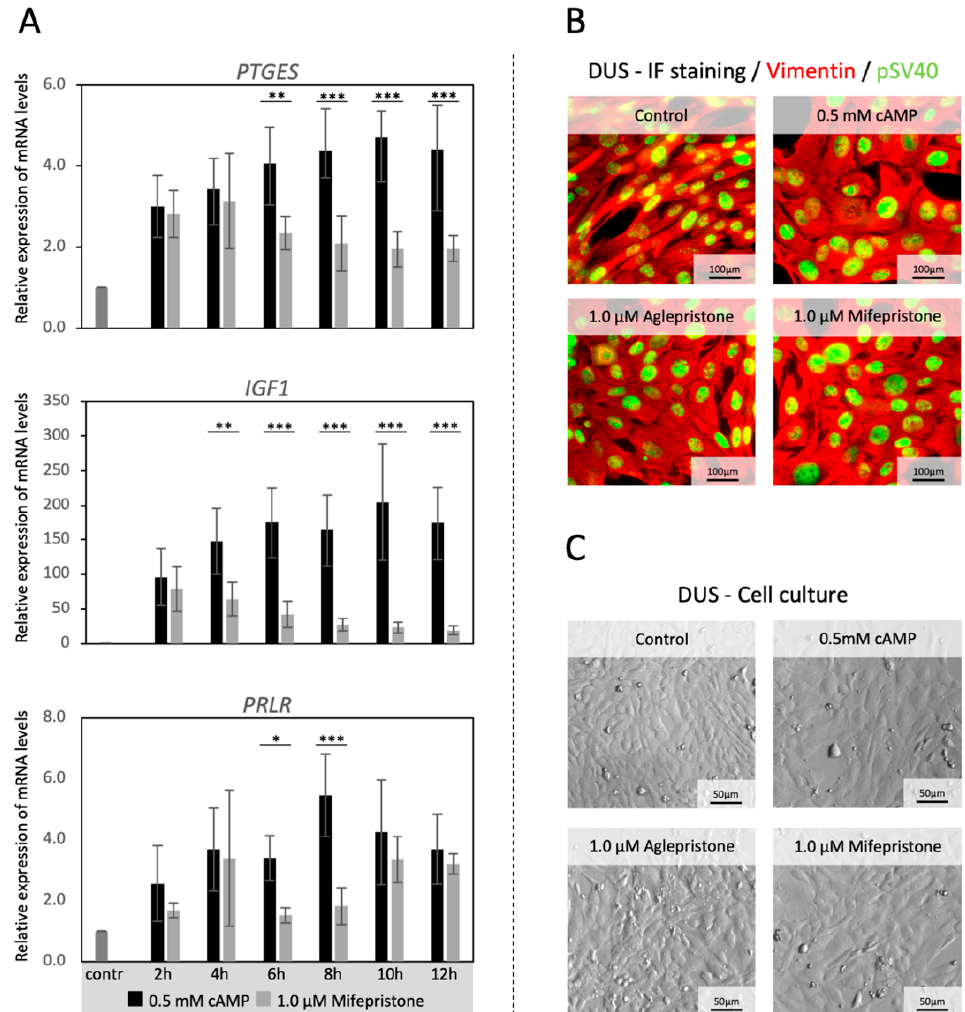
Figure 1. Time-dependent effects of mifepristone on the availability of decidualization markers in DUS cells. ( A ) Decidualized DUS cells (0.5 mM cAMP, 72 h) were treated with 1 μ M mifepristone for up to 12 h. The relative gene expression of prostaglandin E2 synthase ( PTGES ), prolactin receptor ( PRLR ), and insulin-like growth factor ( IGF )-1, was evaluated at different time points of treatment and compared with control cells. Two-tailed Student’s t-test was applied at each time point. Nu- merical data are presented as mean ± standard deviation (SD). Bars with different asterisks differ at: (*) p < 0.05, (**) p < 0.01, (***) p < 0.001. ( B ) Expression of vimentin (VIM, mesenchymal marker—red color) and pSV40 (marker of immortalization—green color) in DUS cells, observed by immunoflu- orescence (IF), after decidualization and/or treatment with antigestagens for 6 h. ( C ) Morphological appearance of DUS cells following in vitro decidualization and/or after 6 h treatment with 1 μ M aglepristone or mifepristone.